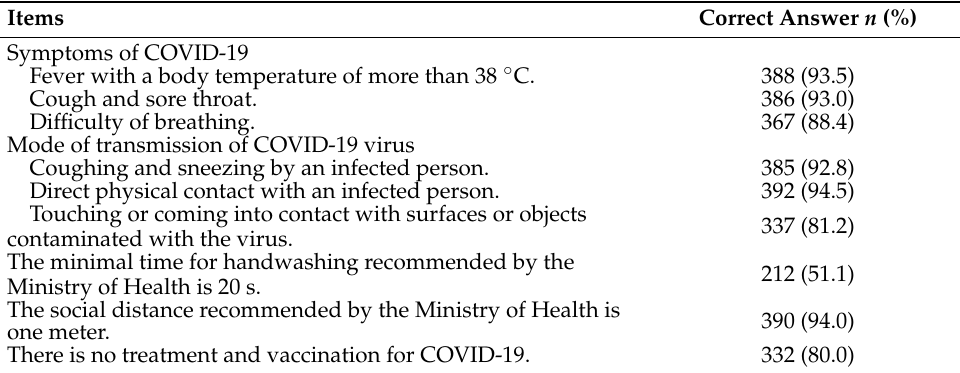
Table 2. Assessment of maternal knowledge on COVID-19.